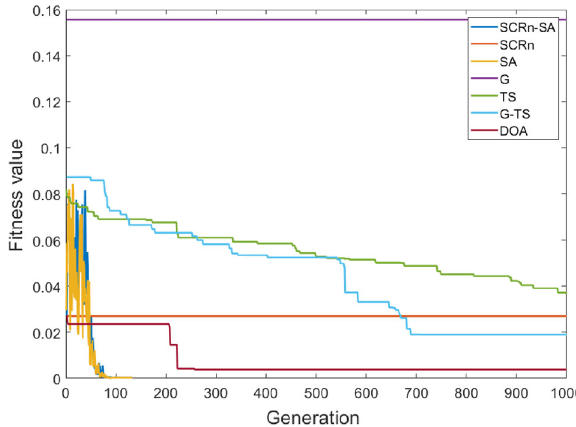
Fig. 15 Convergence curve for D 4